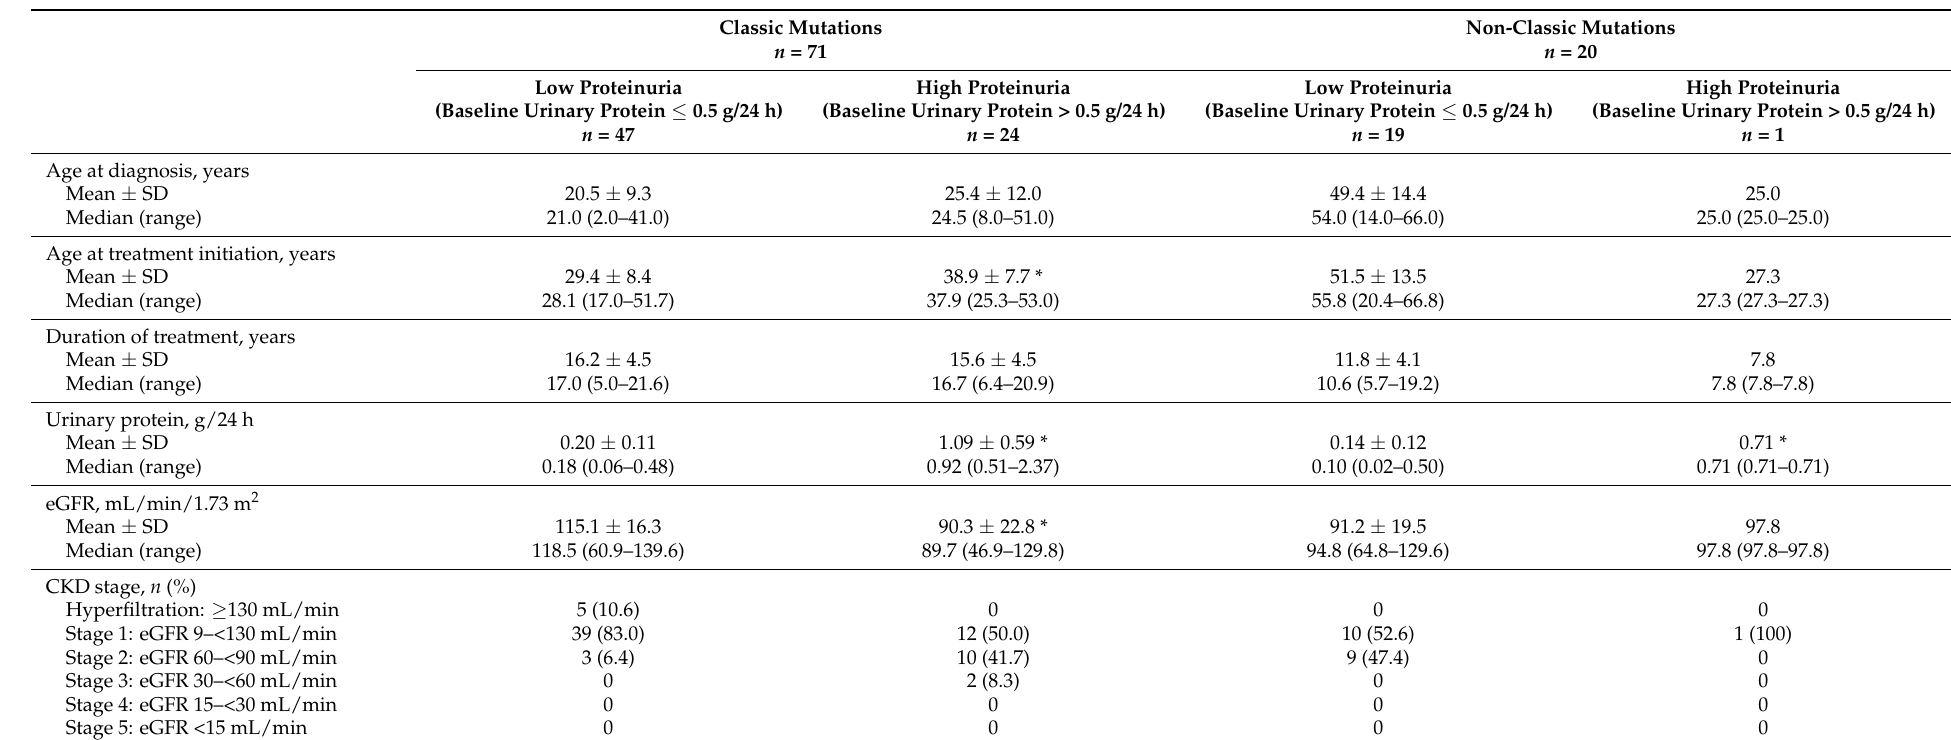
Table 2. Patient characteristics by mutation type and level of proteinuria at